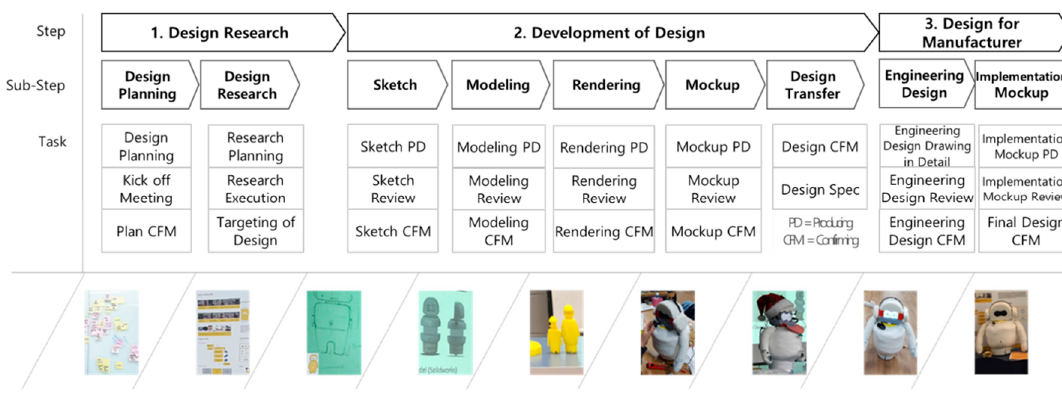
Figure 4. The total design process of physically growing robot “Buddy”.